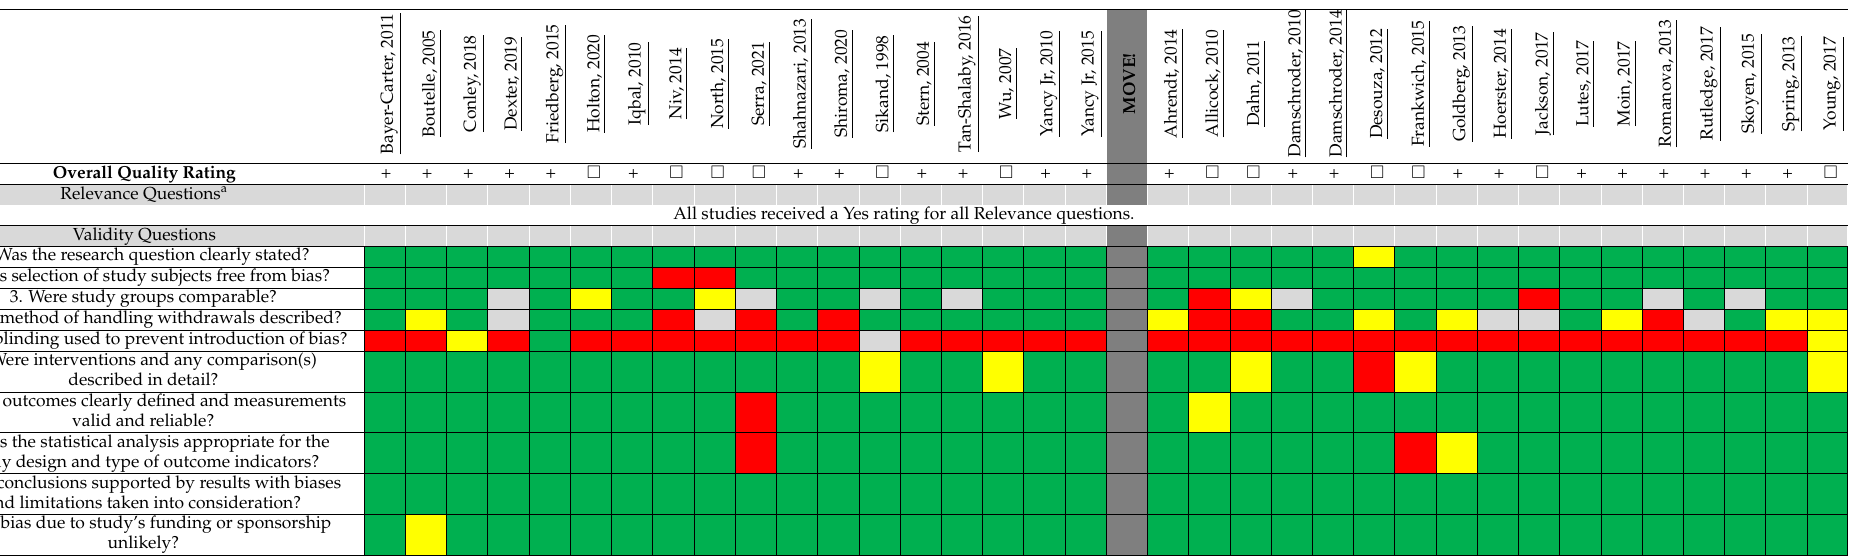
Table 2. Risk of bias